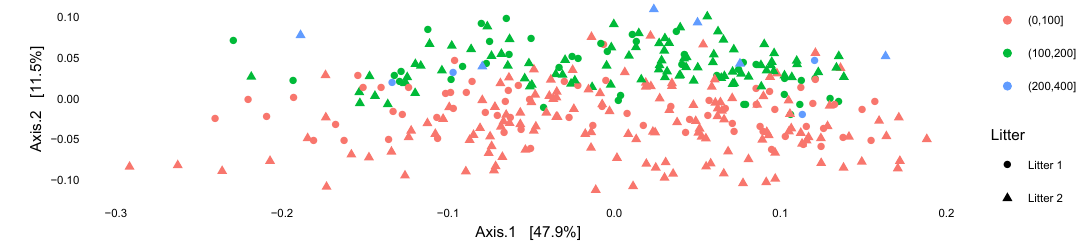
Figure 13. The sample positions produced by a PCoA using weighted Unifrac.